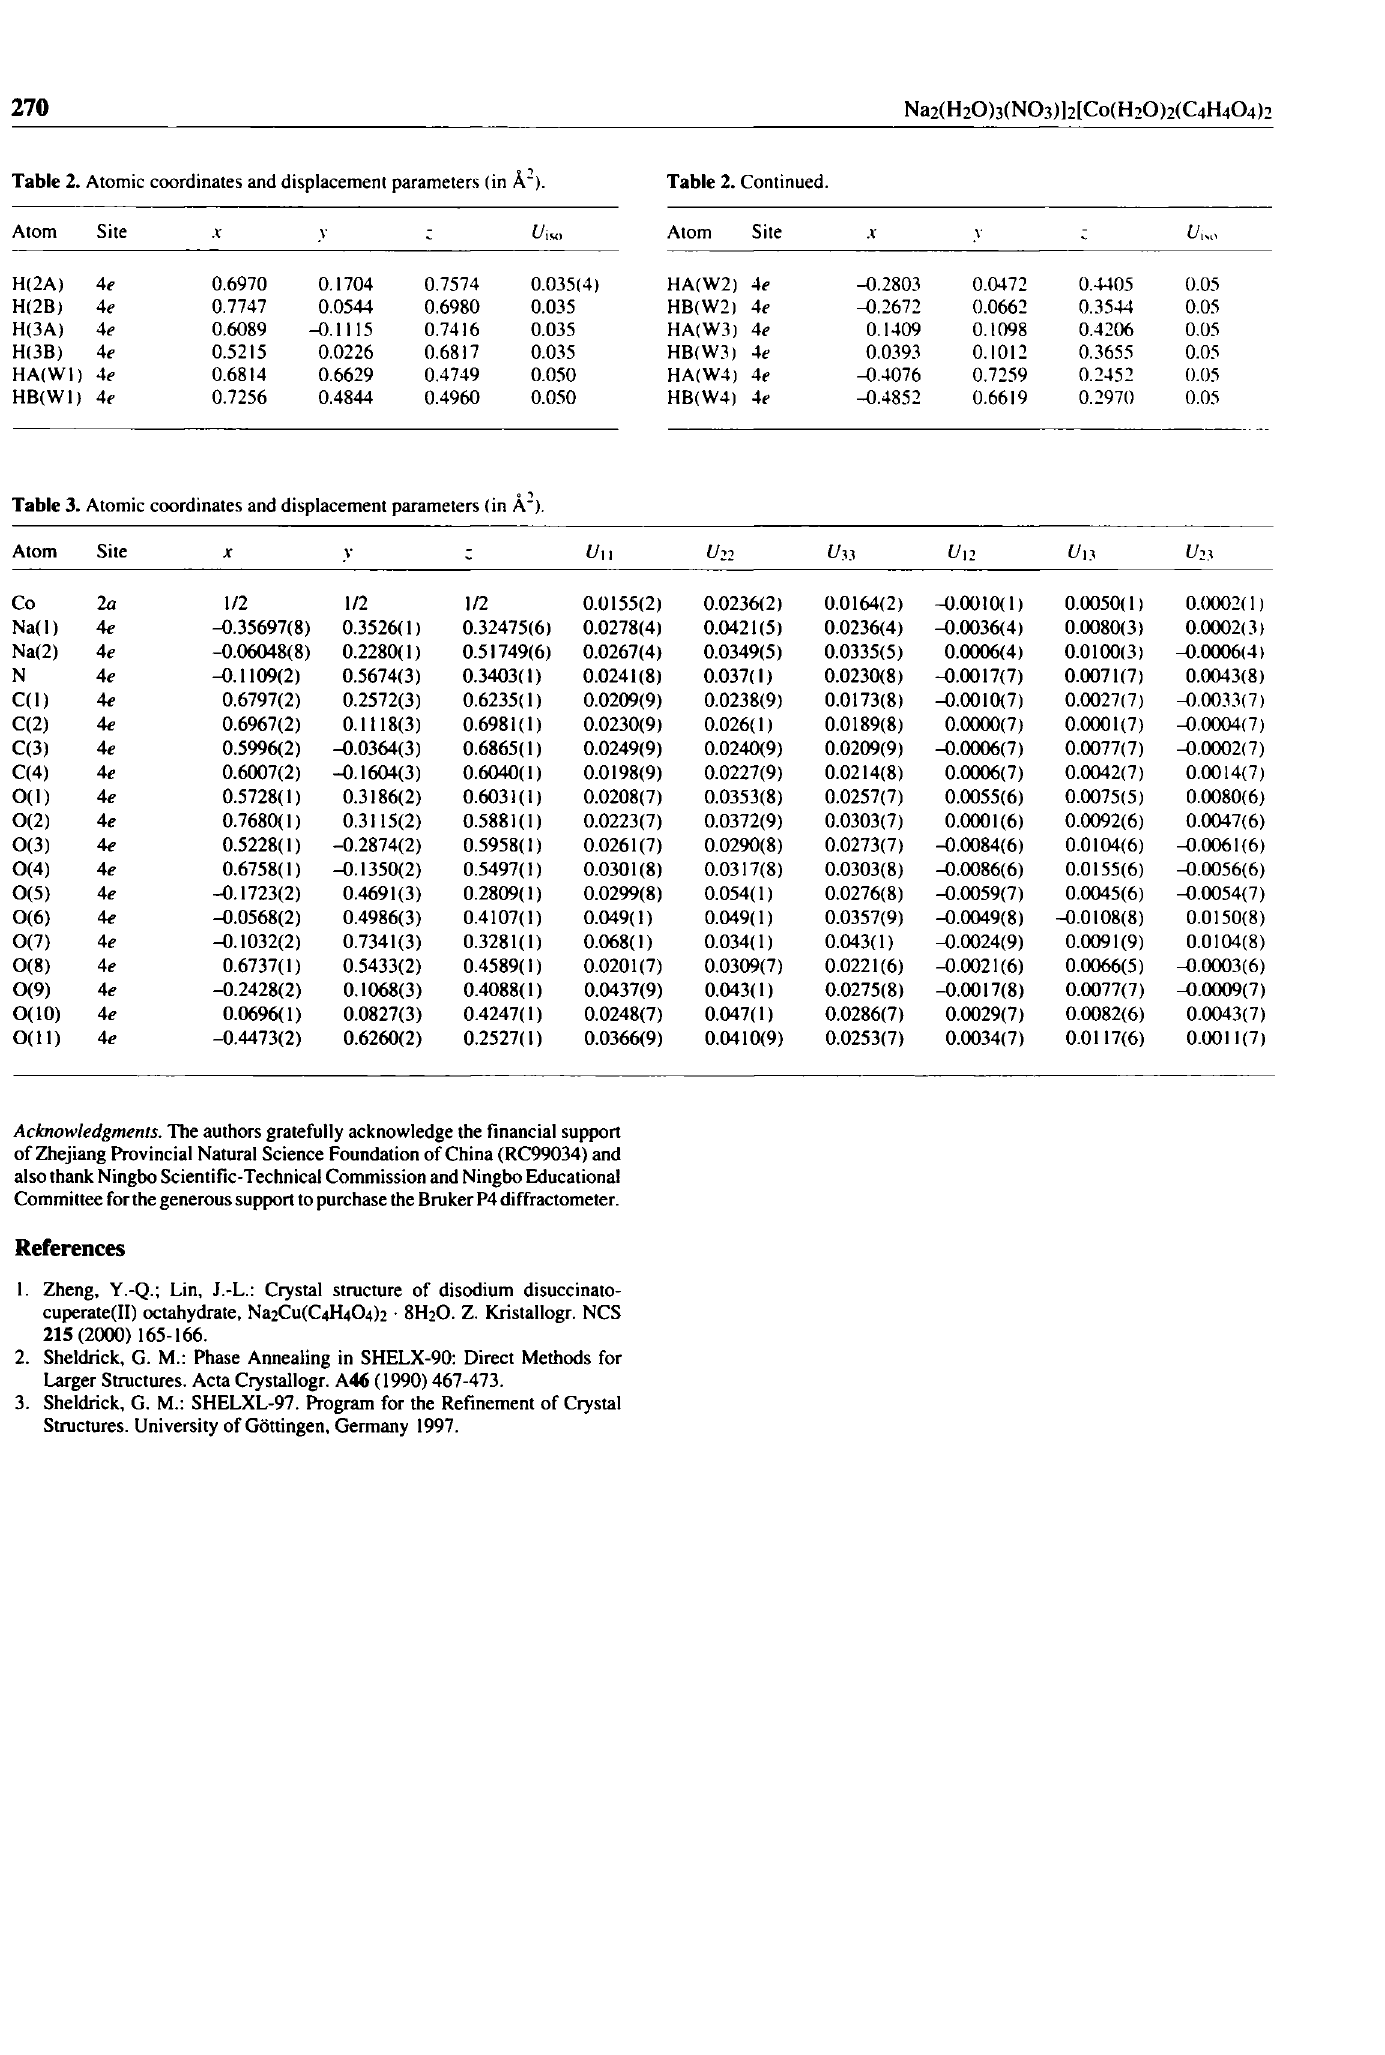
Table 3. Atomic coordinates and displacement parameters (in